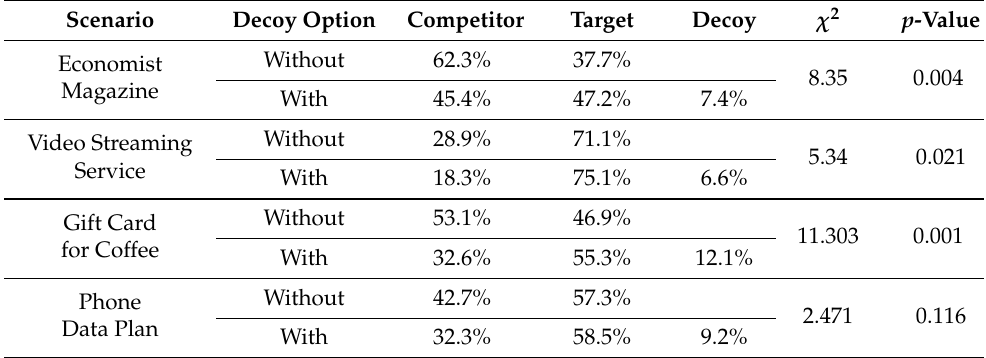
Table 3. Summary of choice probabilities for the decoy placement in each scenario.